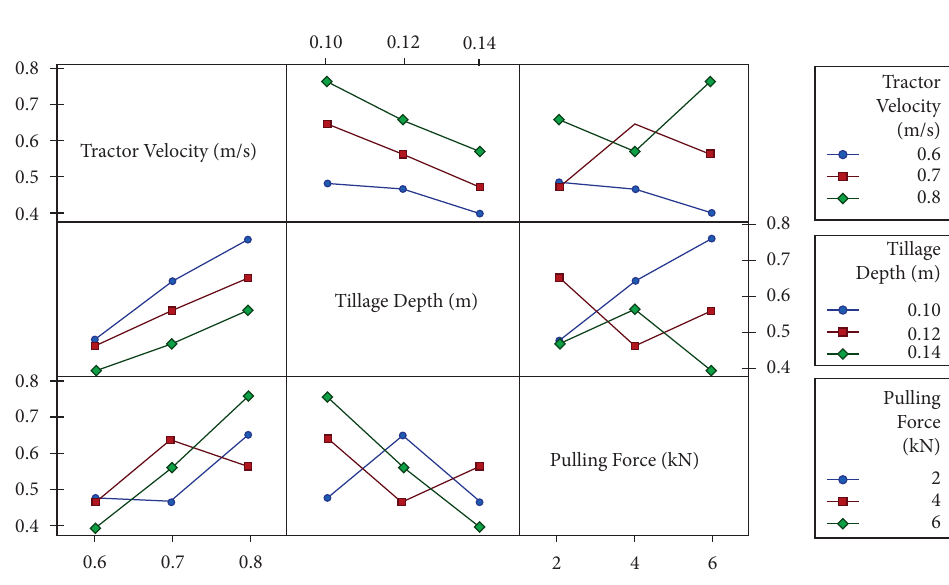
Figure 4: Interaction response of input parameters impacting S